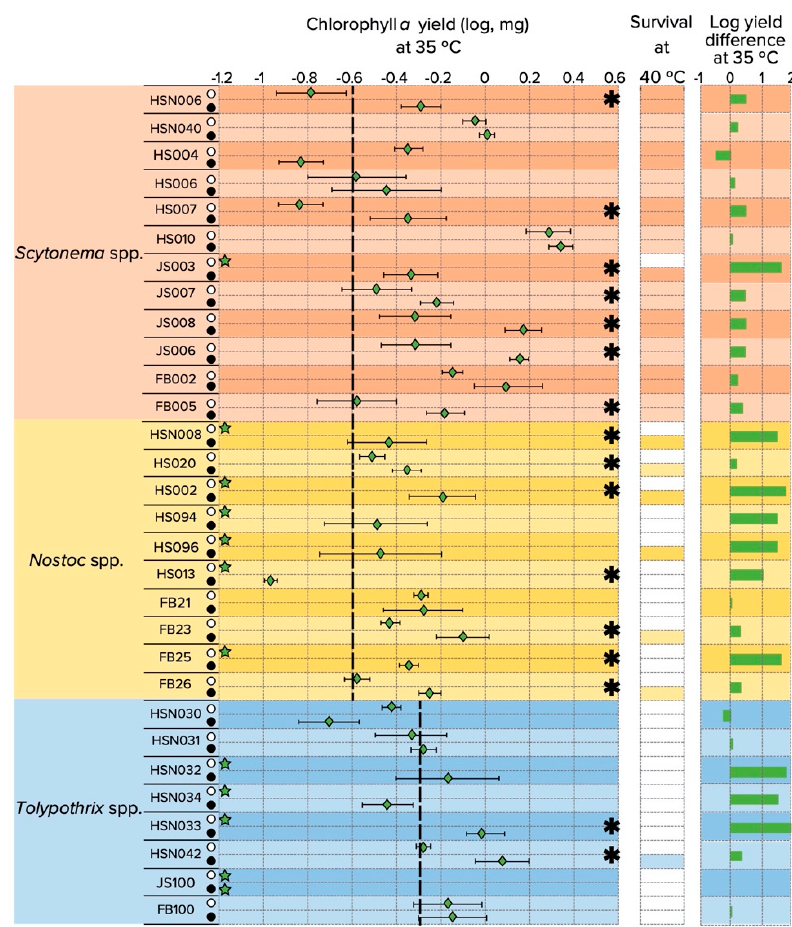
Figure 3. Growth yield of N 2 -fixing cyanobacterial strains in the upper range of temperature for growth in nitrogen free ( ◦ ) vs. nitrogen replete media ( • ). Rhombuses indicate the mean and error bars indicate ± 1 SE, with n = 3. Vertical dashed lines indicate the amount of inoculum provided. At 40 ° C, only observational data were recorded: colored rectangles indicate survival and white rectangles indicate death. * Denotes statistically significant differences between growing conditions according to Wilcox’s test.